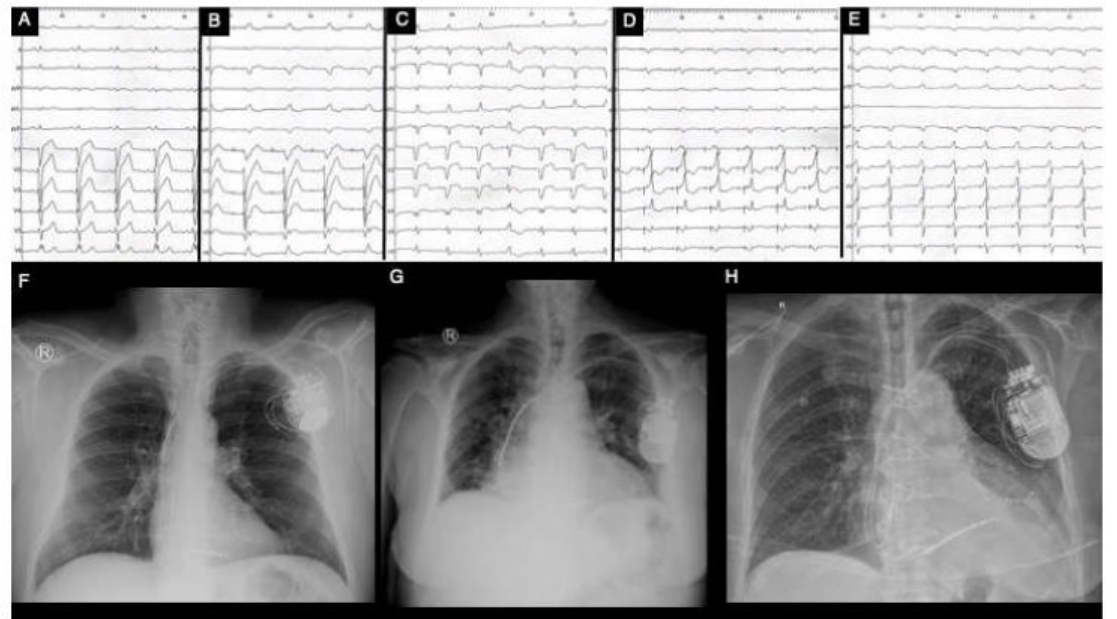
Figure 5. Clinical vignette of LBBB and post-CRT electrical patterns and post-procedural radiological anatomy in patients with hypertrophic cardiomyopathy treated with CRT (own collection of authors). ( A )—typical LBBB activation; ( B )—prior AAIR pacing for sinus node disease with atypical LBBB activation; ( C )—atypical LBBB with apical aneurysm in midventricular hypertrophy pattern HCM; ( D )—DDDR programming with LV-only pacing in optimal fusion intervals in an HCM patient with LBBB; ( E )—DDD programming with biventricular pacing in an HCM patient; ( F )—post-procedural